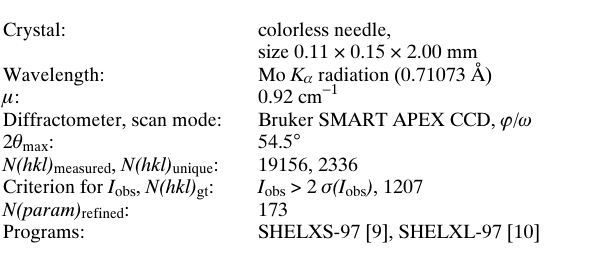
Table 1. Data collection and handling.